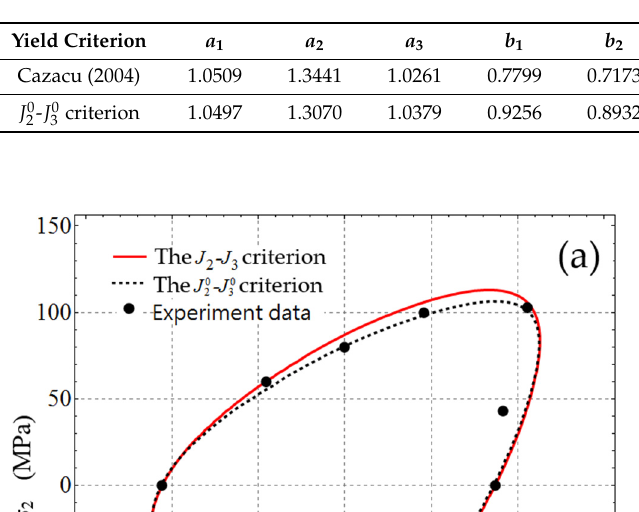
- J 0 criterion and the 2 3